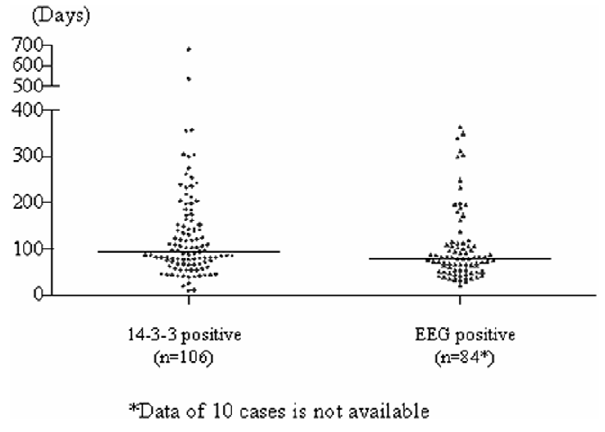
Figure 3. The distribution of the times positively detecting 14- 3-3 in CSF (blue dot) and/or PSWC on EEG (green dot) after the onset in the probable sCJD patients. The black lines indicate the median